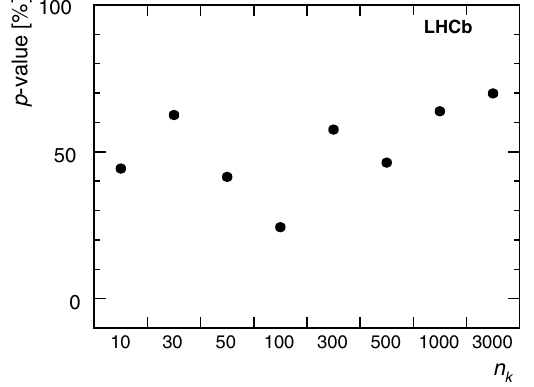
Fig. 10 (Left)thepullvaluesoftheteststatistic T and(right)thecorre- sponding p -value dependence on the n k parameter for the whole Dalitz plot (region R0) for Ξ + c → pK − π + candidate decays obtained using the kNN method for the combined data collected in 2011 and 2012.